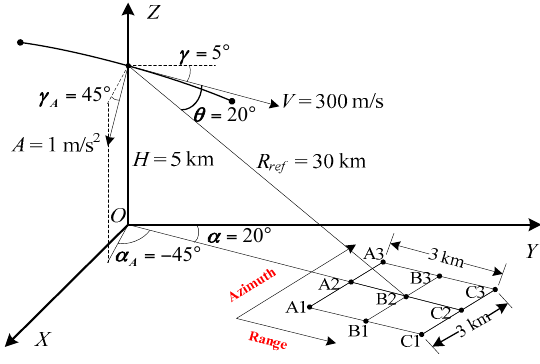
Figure 5. Typical VHS airborne SAR geometry.